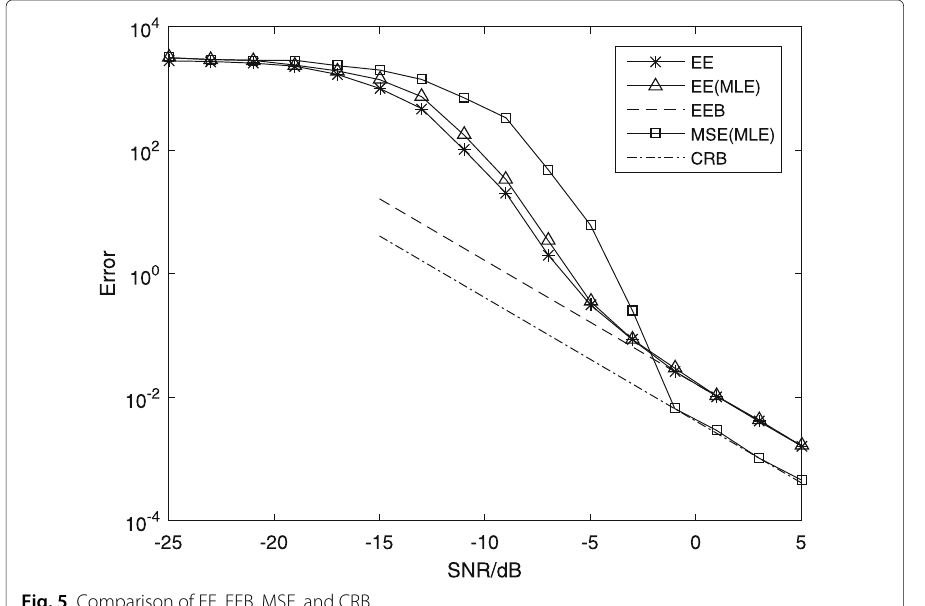
Fig. 5 Comparison of EE, EEB, MSE, and